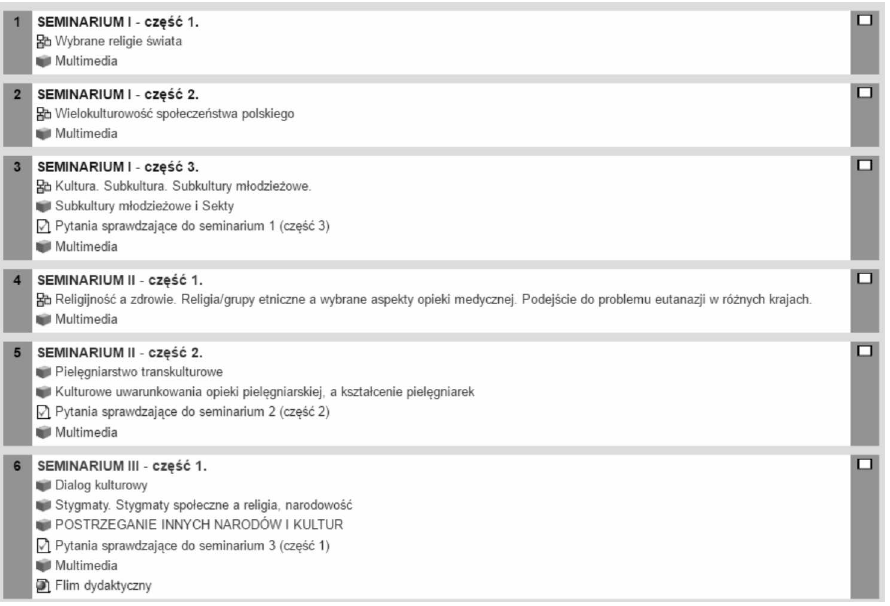
Figure 2. The main window of the course “Problems of multiculturalism in